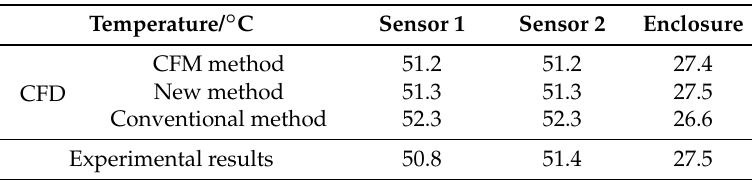
Table 3. Comparison of the experimental and CFD data.